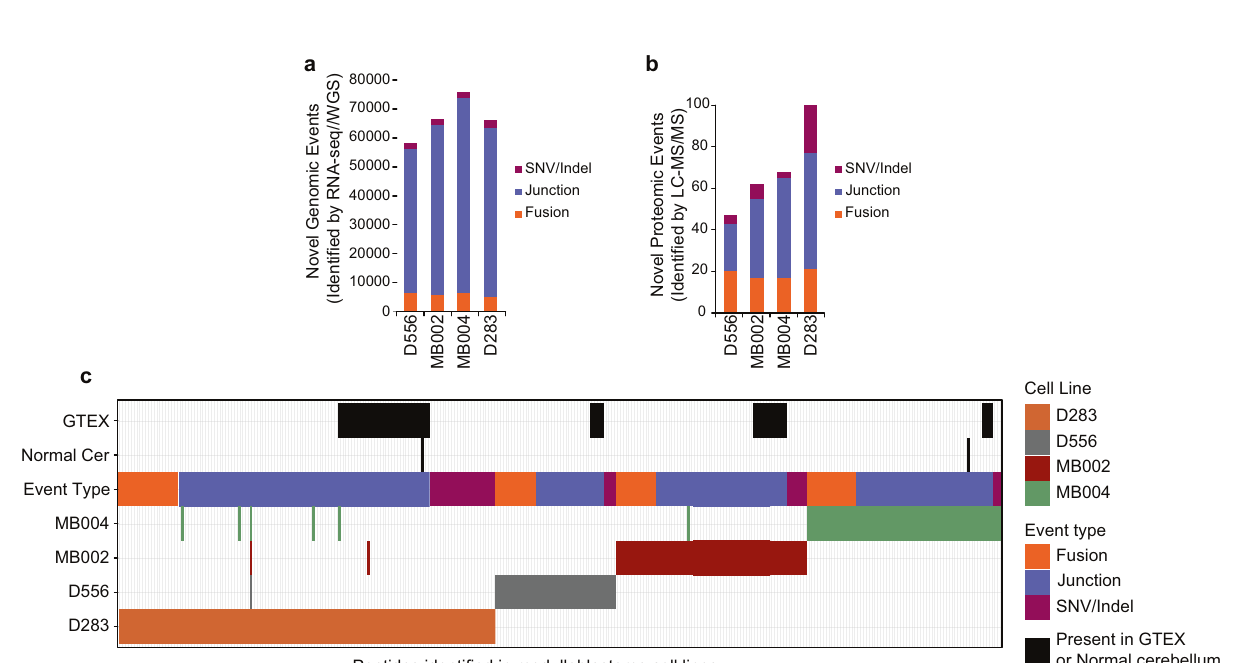
Fig. 3 Autologous tumor-speci fi c peptides induce a speci fi c IFN- γ response. a Tile plot depicting the number of tumor-speci fi c peptides identi fi ed in patient 7316-3778 ’ s tumor. Black tiles indicate the unannotated peptides identi fi ed in healthy cerebellar or normal tissues from GTEX. SNVs, fusions, and junctions are displayed in purple, orange, and blue respectively. b Dendritic cells derived from patients 7316-3778 were loaded with peptides identi fi ed in the subject ’ s tumor by our proteogenomic pipeline. DCs were co-cultured with non-adherent cells as described. Following three stimulations, peptide- speci fi c responses were assessed by anti-IFN- γ ELISpot. In the presence of peptide-loaded DCs, a signi fi cant anti-IFN- γ response was observed against 13/ 15 peptides. One-sided t-test was used to calculate the p -values, n = 4. p -values are indicated in the fi gure, n.s. non-signi fi cant. c Summary data of patient TSAT phenotype, memory, and differentiation status. Gating strategy TSAT populations and phenotypes (Supplementary Fig. 15). d To assess CD4- and CD8-speci fi c cytokine function, TSAT were incubated in the presence of pooled peptides or peptide-loaded DCs. Summary of intracellular staining data showing speci fi c CD4 + and CD8 + responses to 7316-3778 peptides in the presence of peptide-loaded DCs. Gating strategy for intracellular staining (Supplementary Fig. 15). e Results of TCR V β CDR3 sequencing on the 7316-3778 TSA T product. Pie chart of the top 10 clonotypes in the TSA T. Clonotypes are listed in Supplementary Data 5. SFU spot-forming units; 1 SFU = 1 T cell secreting IFN- γ . Actin: speci fi c peptide control; PMA/Ionomycin positive control. Data are presented as mean values + / − SD. Source data are provided as a Source Data fi le.